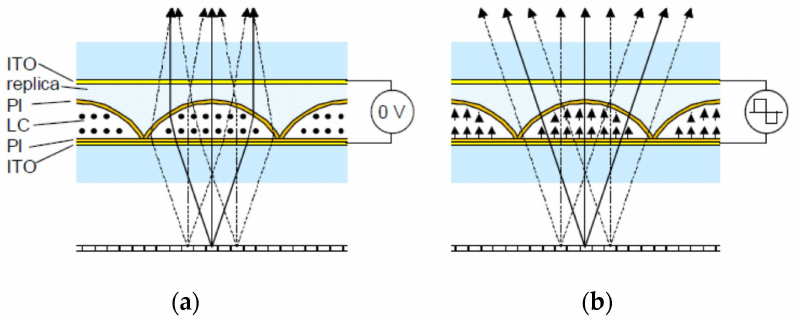
Figure 7. Multilayer liquid crystal lens [53]. Reprinted with permission from Wang, B.; Ye, M.; Sato, S. Applied Optics; published by OSA Publishing, 2004. Figure 8. Active birefringent lens: ( a ) without voltage and ( b ) with voltage [55]. Reprinted with permission from Willemsen, O.H.; de Zwart, S.T.; IJzerman, W.L.; Hiddink, M.G.H.; Dekker, T. International Society for Optics and Photonics; published by SPIE, 2006.